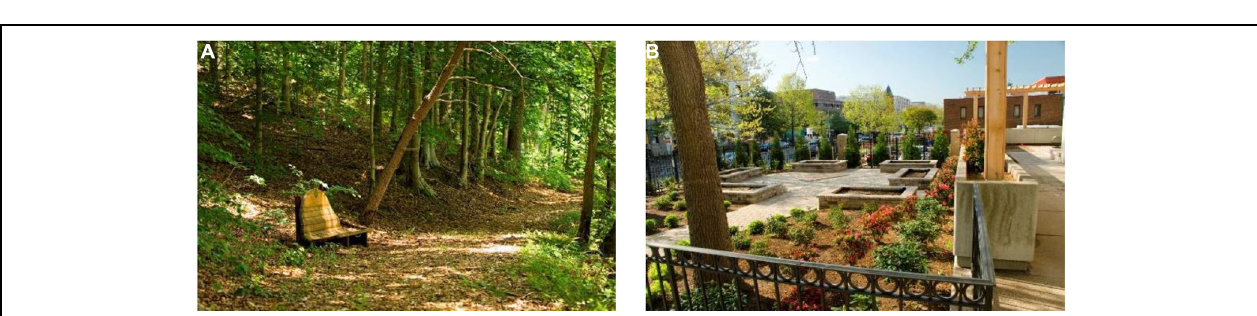
FIGURE 5 | Comparison of two images with different values of disorganized edge ratios: (A) Example of an image containing high ratio of non-straight edges relative to total ED, DER = 0.84 (B) Example of an image containing low ratio of non-straight edges relative to total ED, DER = 0.41.